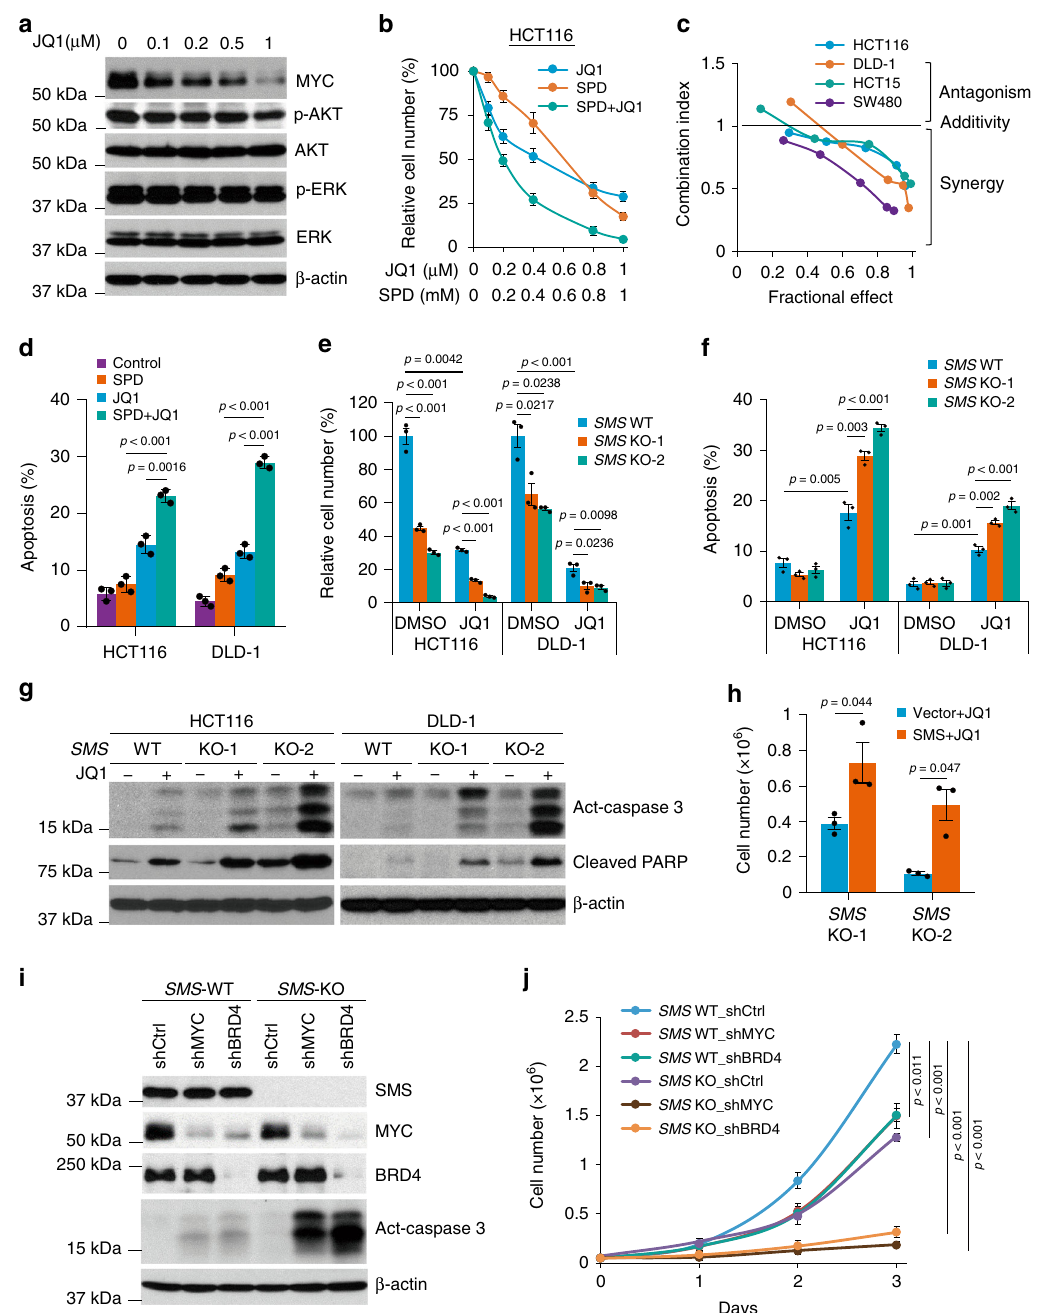
Fig. 3 Downregulation of both SMS and MYC synergistically induces apoptosis in CRC cells. a HCT116 cells were treated with the indicated concentration of JQ1 for 24 h, followed by western blot analysis for the indicated proteins. b HCT116 cells were treated with JQ1 and spermidine (SPD), alone or in combination, with the indicated concentrations for 72 h. Results are expressed as a percentage of viable cell number relative to the value obtained in DMSO-treated control cells. c The indicated cells were treated with a combination of JQ1 and SPD. Combination index values were determined using the Chou – Talalay method for drug combinations with a fractional effect between 0.20 and 0.99 (20 – 99% of cell growth inhibition relative to control). d Apoptosis was assessed in HCT116 and DLD-1 cells treated for 72 h with 1 µ M JQ1 and 1 mM SPD, alone or in combination, or with DMSO as control. e SMS -WT or SMS -KO HCT116 and DLD-1 cells were assessed for cell growth after 72 h of treatment with 1 µ M JQ1 or with DMSO as control. Results are expressed as a percentage of cell number relative to the values obtained with DMSO-treated SMS -WT cells. f Apoptosis was assessed in SMS - WT or SMS -KO HCT116 and DLD-1 cells treated with 1 µ M JQ1 or with DMSO as control for 72 h. g SMS -WT or SMS -KO HCT116 and DLD-1 cells were treated with 1 µ M JQ1 or DMSO for 24 h, followed by western blot analysis for the indicated proteins. h SMS -KO HCT116 cells with re-expression of SMS or vector control were treated with 1 µ M JQ1 for 3 days, followed by counting the number of viable cells. ( i, j ) SMS -WT or SMS -KO HCT116 cells with stable expression of MYC shRNA (shMYC), BRD4 shRNA (shBRD4) or control shRNA (shCtrl) were analyzed by western blot for the indicated proteins ( i ), or assessed for cell growth ( j ). Data are presented as mean values ±SEM ( n = 3 independent experiments) in b , d – f , h and j . The indicated p -values were determined by two-tailed unpaired t test. Source data are provided as a Source Data fi